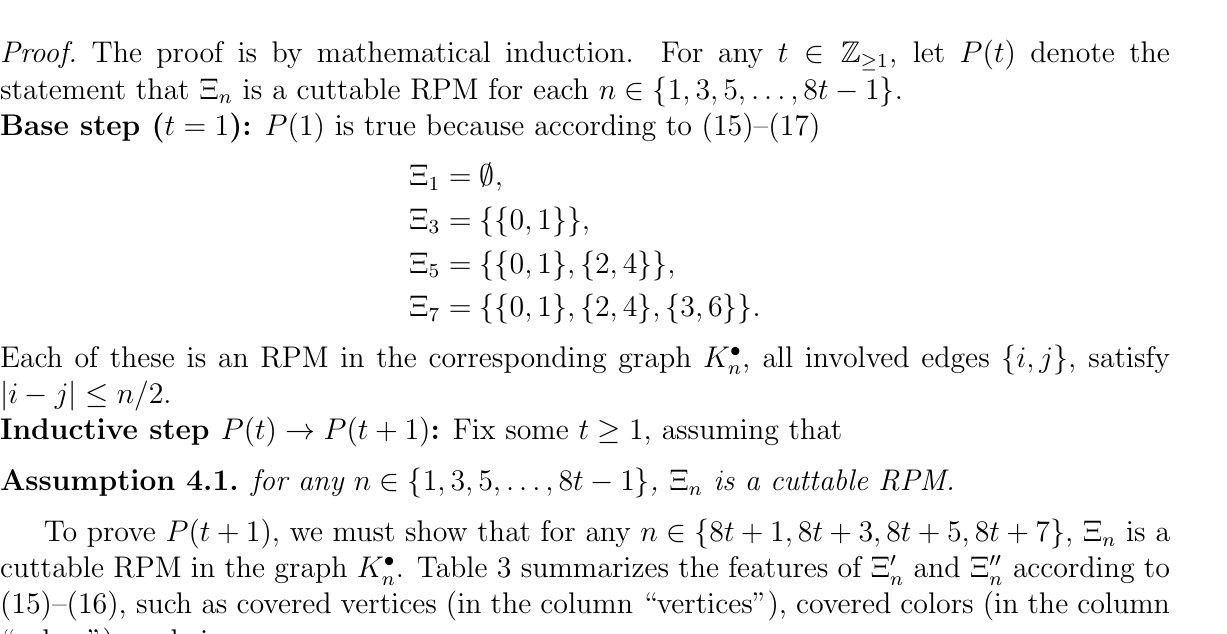
Table 3: Features of Ξ (cid:48)